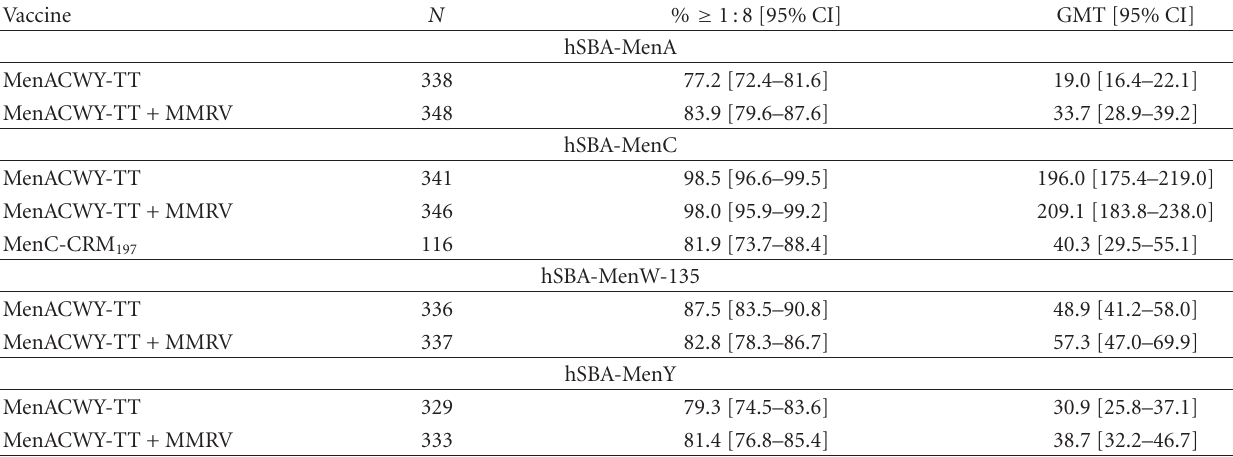
Table 7: Percentage of subjects with hSBA titres ≥ 1 :8 and hSBA GMTs against serogroups A, C, W-135, and Y at 42 days after one dose of MenACWY-TT in toddlers (ATP immunogenicity